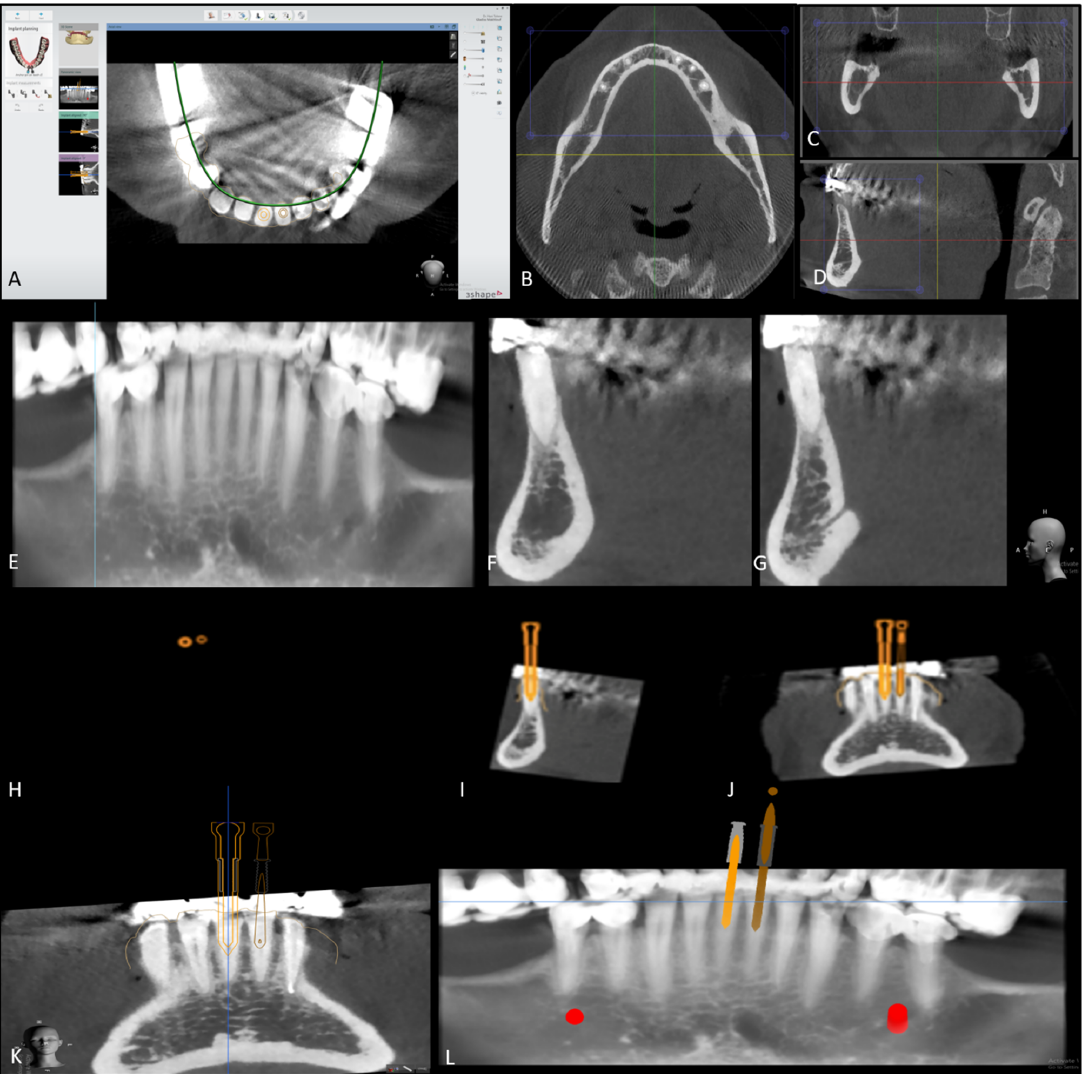
Figure 2. (A) Axial view of inferior jaw on Implant studio software. (B) Axial view of the mandible. ( C ) Transversal view. ( D ) Sagittal view. ( E ) Panoramic view. ( F ) Sagittal view of tooth 31, showing (C) Transversal view. (D) Sagittal view. (E) Panoramic view. (F) Sagittal view of tooth 31, showing severe calcification of the canal. ( G ) Sagittal view of tooth 41, showing severe calcification of the canal. severe calcification of the canal. (G) Sagittal view of tooth 41, showing severe calcification of the canal. ( H ) Axial view of the virtual drill’s preparation. ( I ) Sagittal view of the virtual drill’s preparation (H) Axial view of the virtual drill’s preparation. (I) Sagittal view of the virtual drill’s preparation and